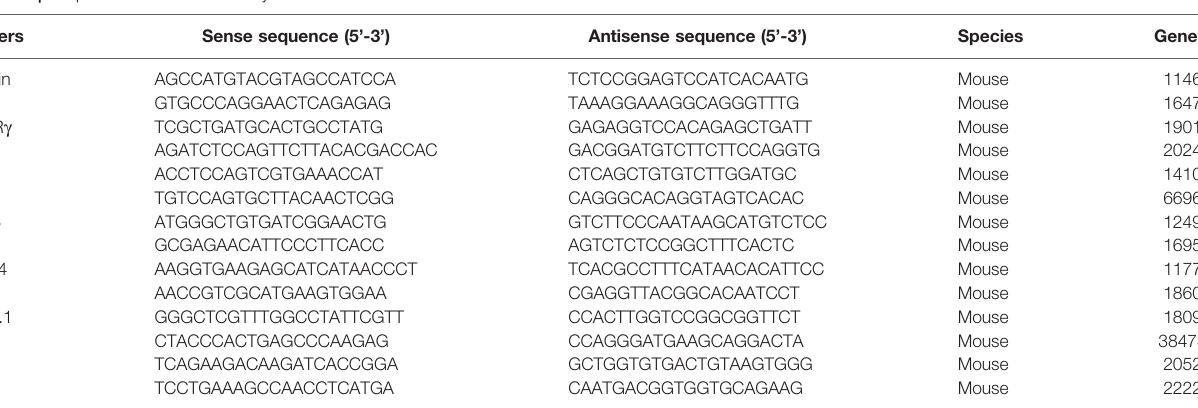
TABLE 2 | Sequences used in this